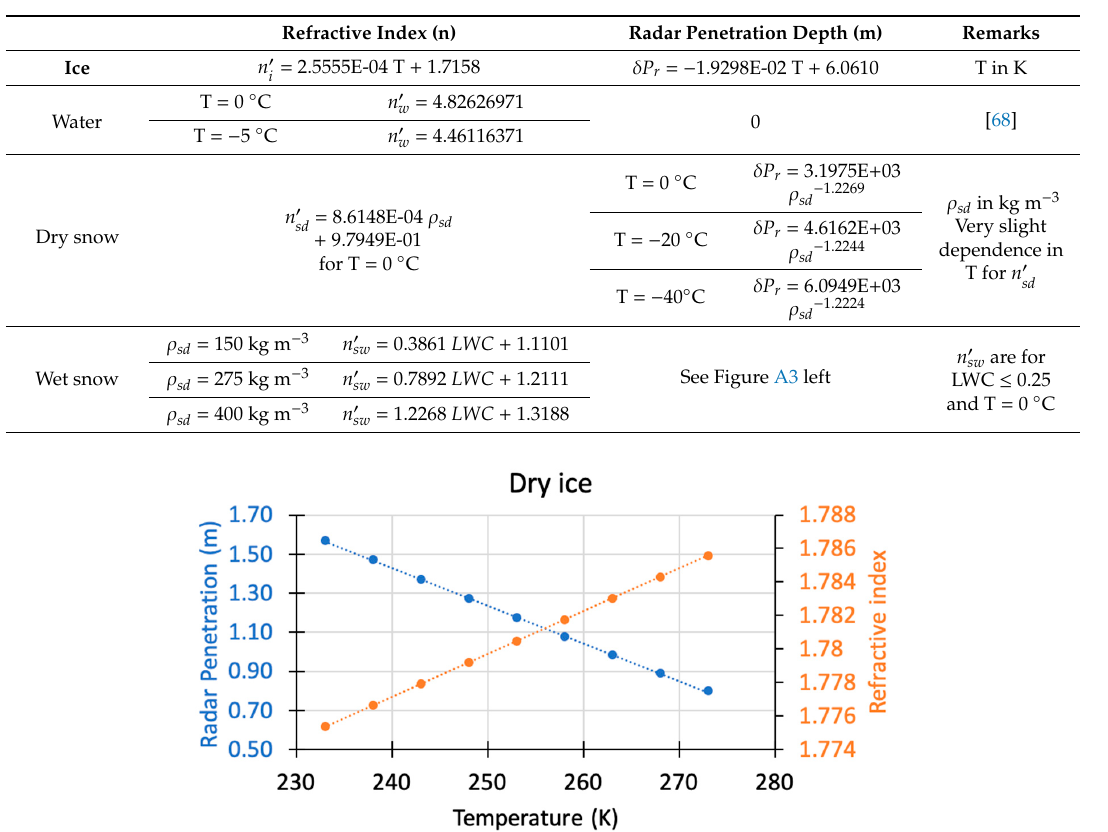
Table A1. Relationship between the refractive index and radar penetration depth for ice, dry snow and wet snow. Fits were derived based on SMRT code permittivity values [67]. Note that some of them are unit dependent. See Figures A1–A3 below.